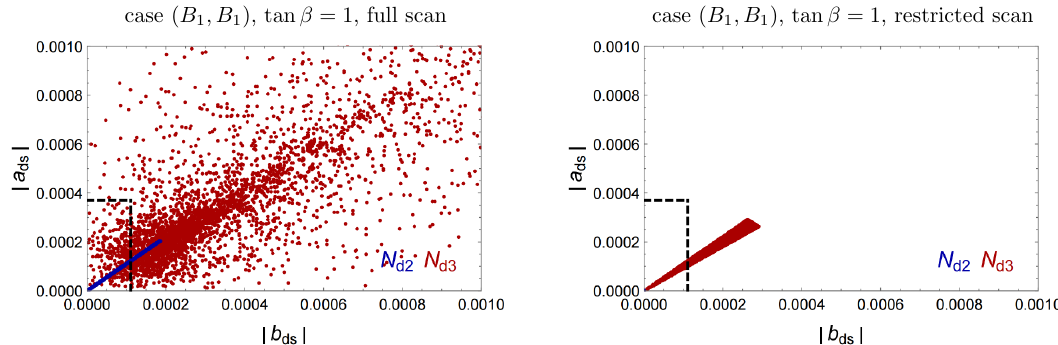
Figure 2 . The impact of kaon oscillations. Shown are the values of | a ds | , | b ds | obtained in a full scan (left) and a restricted scan with θ eq. (3.3a).